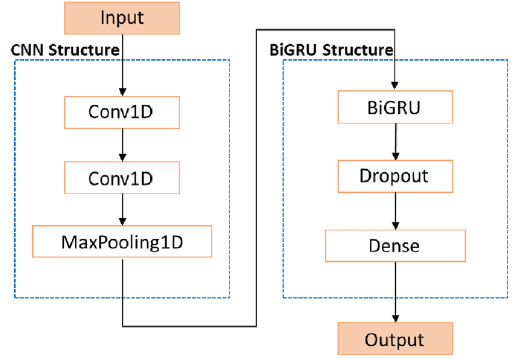
Figure 8. The structure of